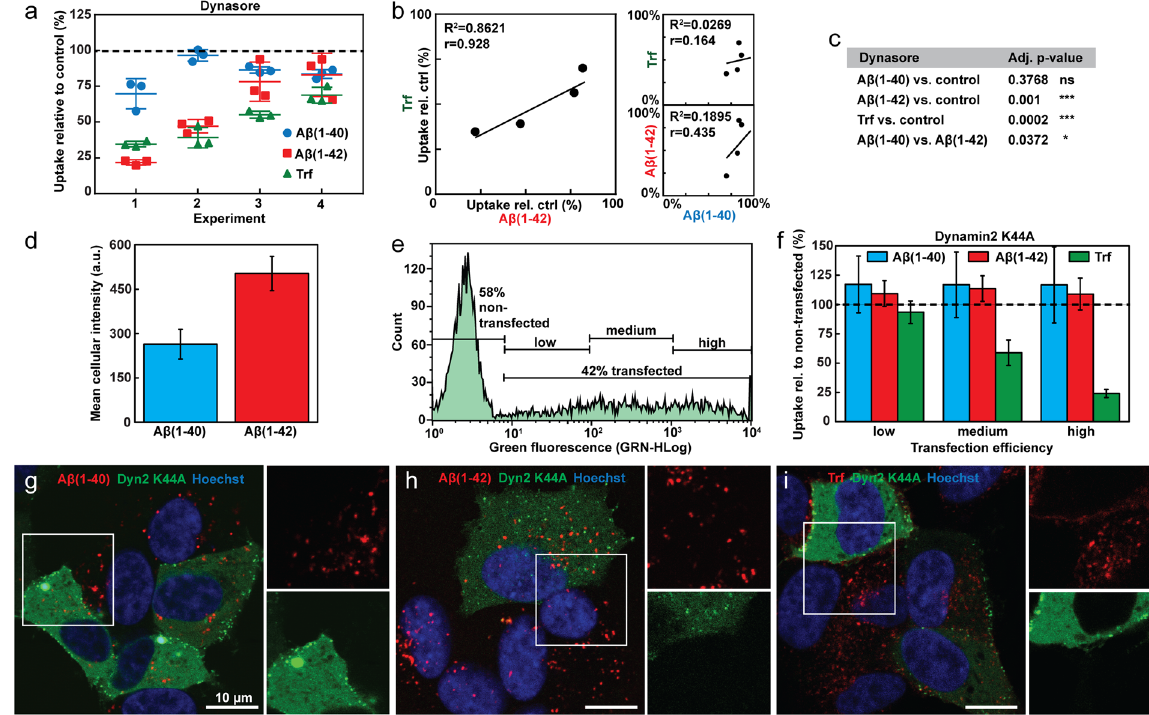
Figure 3. Uptake of A β (1–40), A β (1–42) and Trf in SH-SY5Y cells under conditions that perturb dynamin dependent endocytosis. ( a ) Uptake of HF488-labelled A β (1–40), A β (1–42) and AF647-labelled Trf in cells treated with dynasore (80 µ M). The peptide uptake is reported as mean cellular uptake relative to control (cells not treated with inhibitor) for 4 independent experiments, each performed in triplicate. ( b ) Correlation analysis of the data presented in ( a ) with R 2 of the linear fit of average inhibitions levels from each experiment and treatment, and Pearson’s correlation coefficient (r). ( c ) Statistical analysis of the data in ( a ) performed by one-way ANOVA with matched data followed by multiple comparisons with Bonferroni post-hoc test. The table shows the adjusted p-values for the individual comparisons made ( * p ≤ 0.05, ** p ≤ 0.01, *** p ≤ 0.001). ( d ) Mean cellular intensity ± SD (N = 2, n = 3–5) of live cells after incubation with HF647-labelled A β (1–40) or A β (1–42). ( e ) Flow cytometry histogram of live cells 24 h post transfection with EGFP-labelled dyn2 K44A: the cells were gated for peptide uptake based on transfection efficiency and the extent of dyn K44A overexpression as measured by the intensity of the EGFP label. ( f ) Uptake of HF647-labelled A β (1–40), A β (1–42) or AF647- labelled Trf in dyn2 K44A transfected cells, gated as in ( e ) and related to peptide uptake in cells gated as non-transfected (N = 2, n = 3–5). ( g – i ) Confocal imaging of dyn2 K44A (green) transfected cells imaged 24 h post transfection and incubated with HF647-labelled ( g ) A β (1–40), ( h ) A β (1–42) or ( i ) AF647-labelled Trf (red). In all experiments the concentration of A β was 1 μ M and the concentration of Trf was 5 µ g/ml. Cells were incubated with A β for 1 h and Trf for 5 min (flow cytometry) or 10 min (confocal microscopy). Relative uptake was calculated based on mean cellular fluorescence intensity ± SD of the total number of gated live cells measured by flow cytometry. All flow cytometry data were corrected for baseline contributions by subtracting the cellular